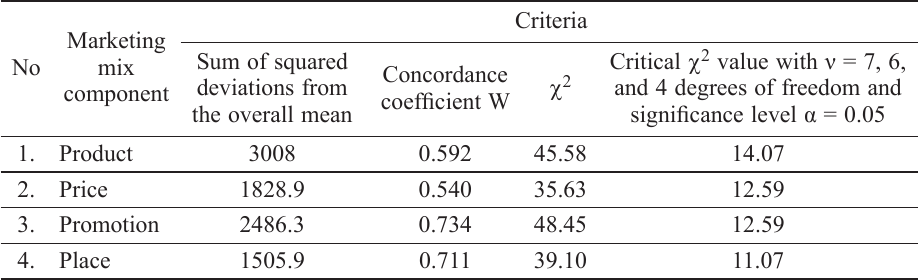
Table 1. The verification results of the consistency of the criteria weights of the marketing mix elements elicited from